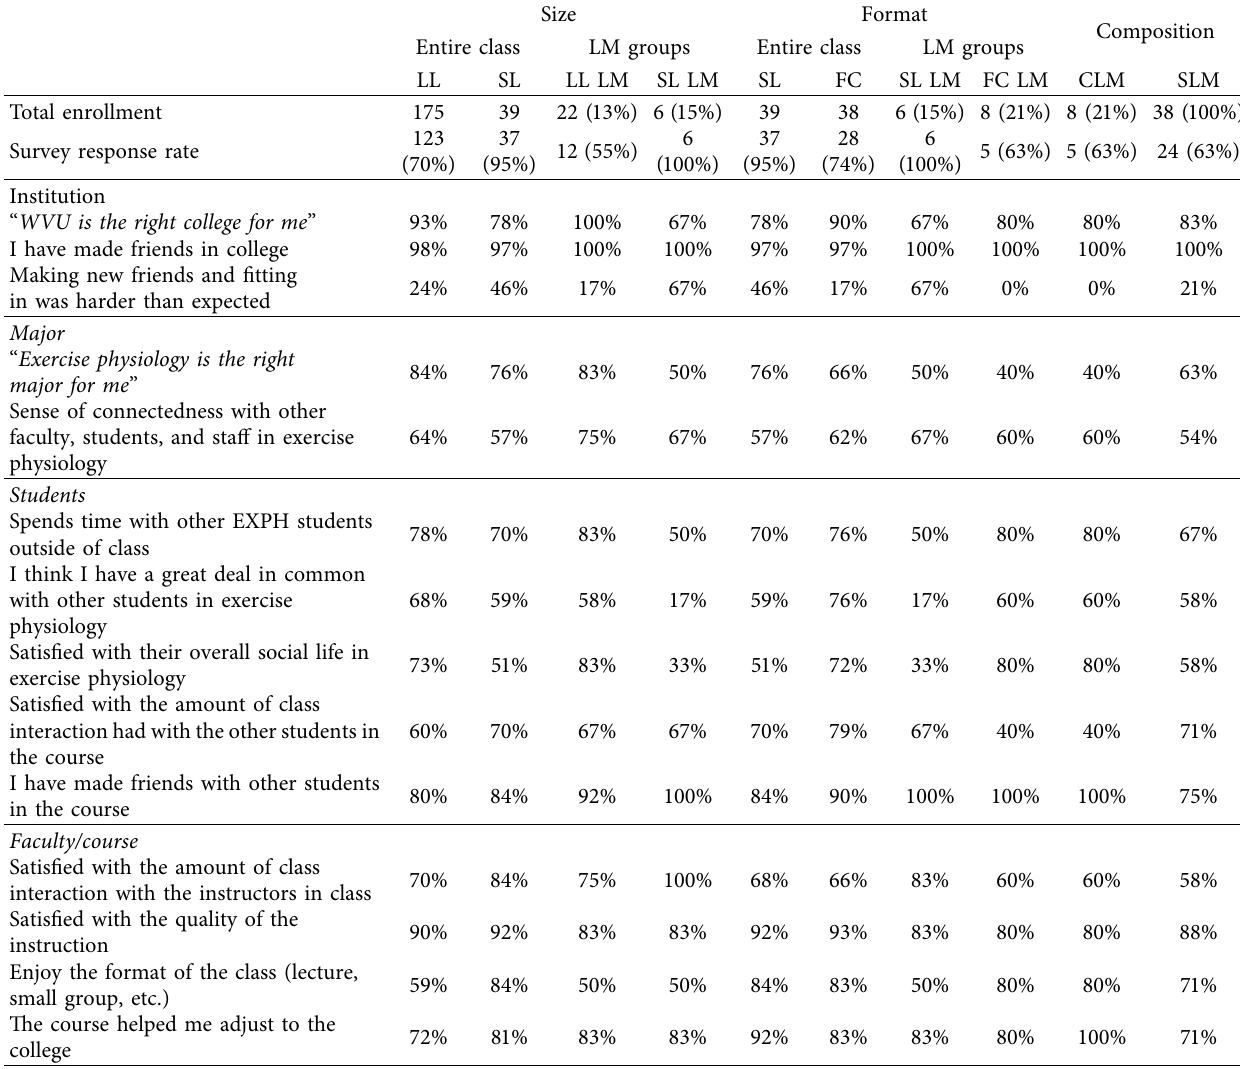
Table 1: Social integration survey responses.